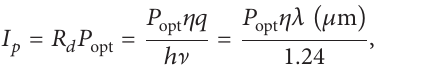
Figure 8: Nonvolatile flash-memory cell proposed with 2D struc-